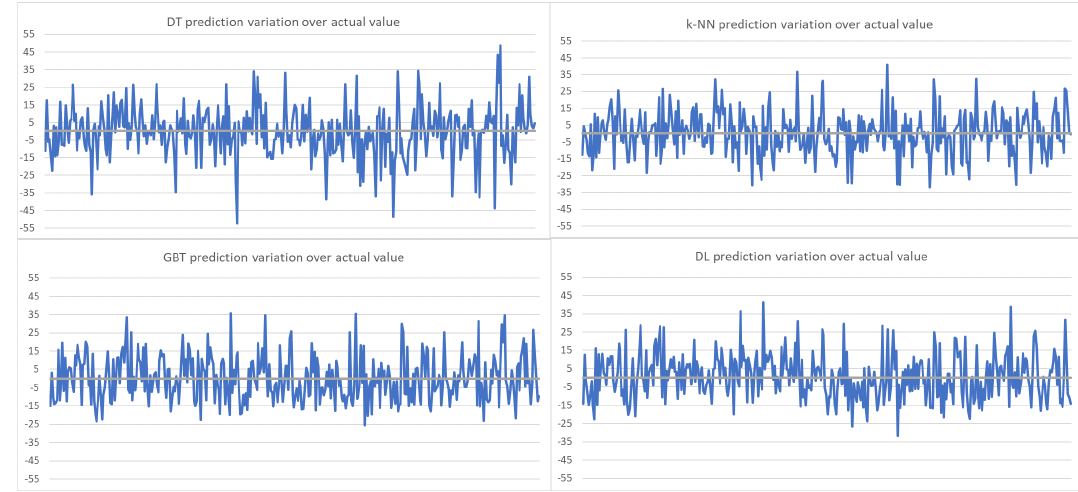
Figure 12. Prediction variation overview for Sarmasu: CADM + CDM 3 sources scenario for DT & k-NN (upper side) and GBT & DL (lower side) the values for the deviation of predicted value versus actual value ( X -axis) and the time series for which the results were registered ( Y -axis). Table 8. Standard deviation overview per algorithm for Sarmasu in the CADM + CDM 3 sources scenario. Alg Value Standard Deviation Standard